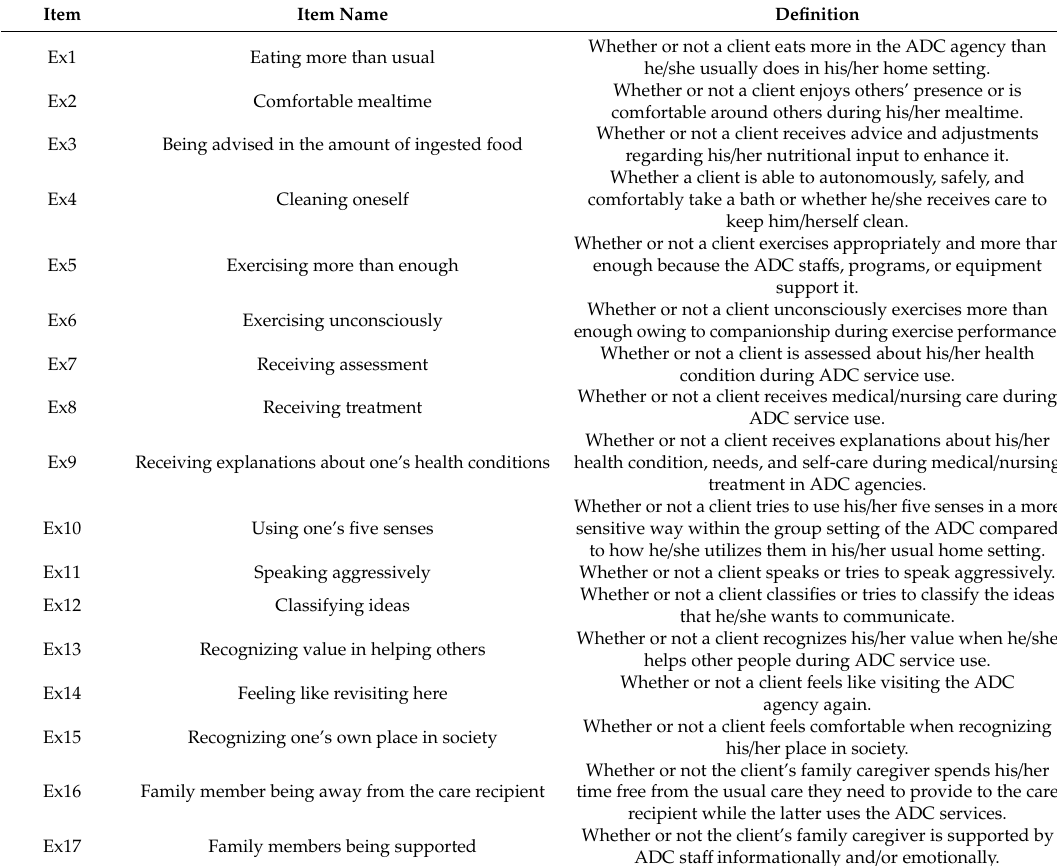
Table 1. Questionnaire items about clients’ / family members’ experience regarding adult day care service